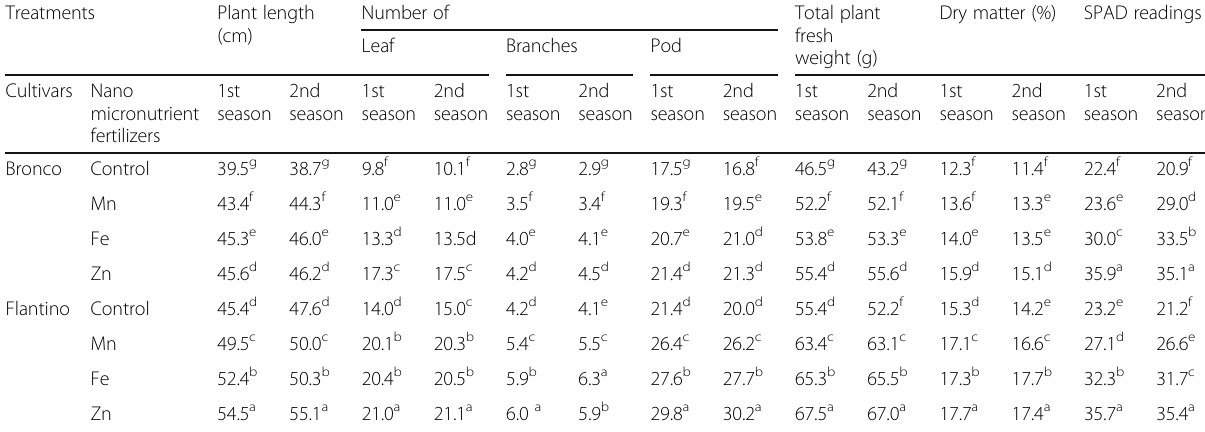
Table 4 Effect of interaction between cultivars andnano micronutrient fertilizerson vegetative growth of snap bean plants during 2017 and 2018 seasons